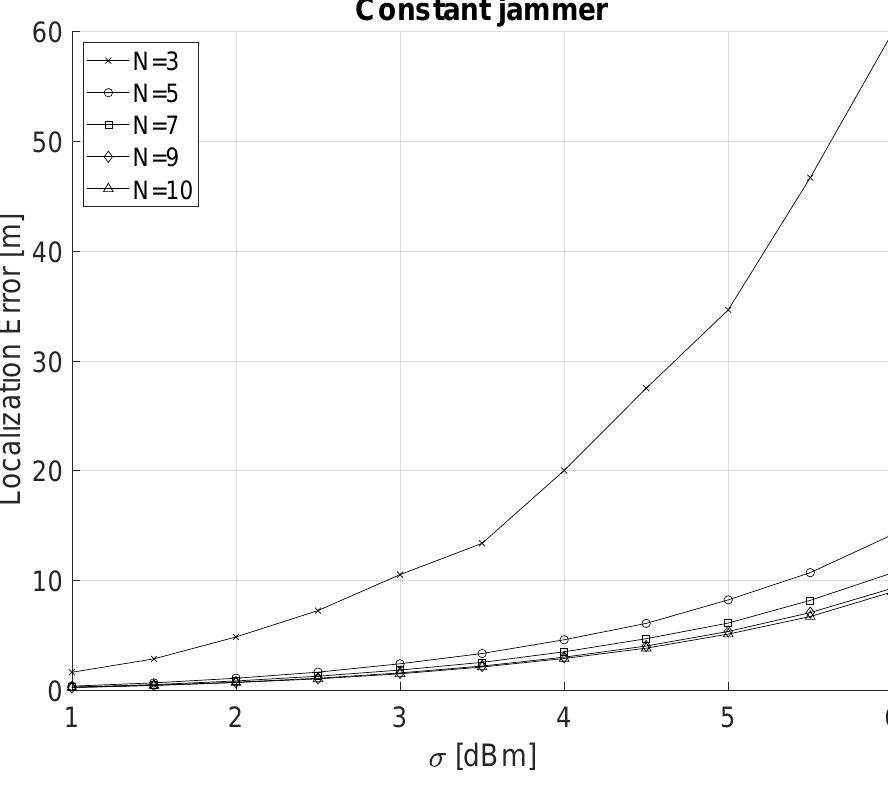
Figure 4. Localization of a constant jammer as a function of σ (1 dBm ≤ σ ≤ 6 dBm) and the number N of sensing nodes (3 ≤ N ≤